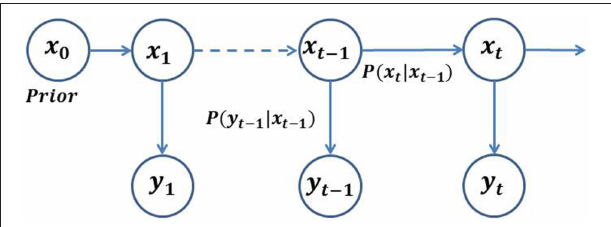
FIGURE 1 | General architecture of an HMM. The random variable X t is the hidden state at time t . The random variable Y t is the observation at time t . The arrows in the diagram denote conditional